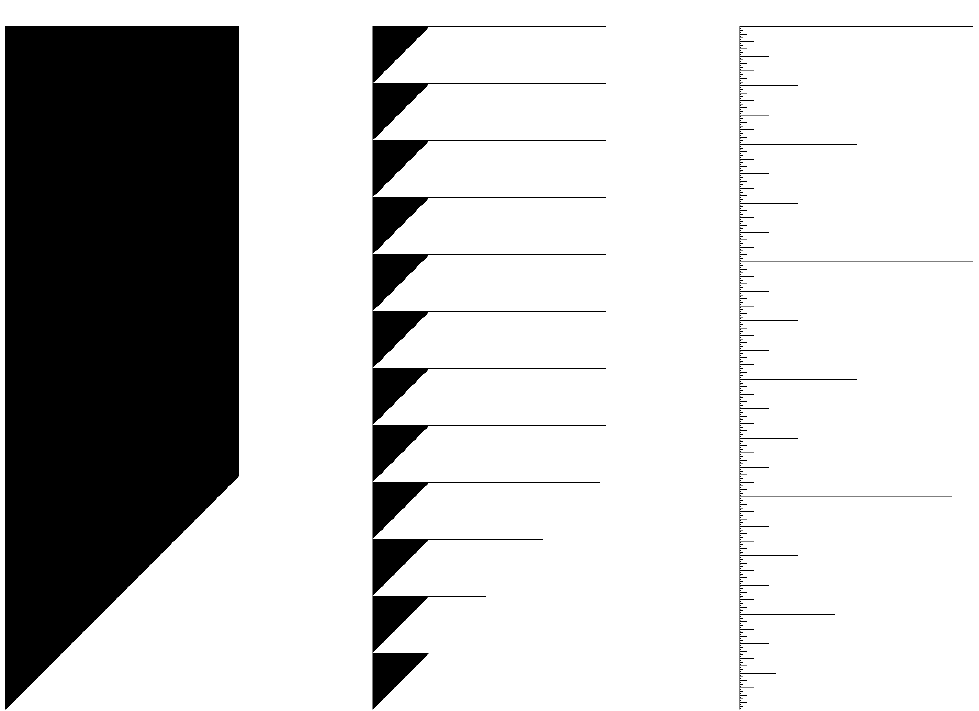
Figure 12.2: Three jump strategies for 744 divstep iterations on 255-bit integers. Left strategy: j = 1; i.e., computing each divstep in turn to full precision. Middle strategy: j = 1 for ≤ 62 requested iterations, else j = 62; i.e., using 62 bottom bits to compute 62 iterations, jumping 62 iterations, using 62 new bottom bits to compute 62 more iterations, etc. Right strategy: j = 1 for 2 requested iterations, j = 2 for 3 or 4 requested iterations, j = 4 for 5 or 6 or 7 or 8 requested iterations, etc. Vertical axis, 0 on top through 744 on bottom: number of iterations. Horizontal axis (within each strategy), 0 on left through 254 on right: bit positions used in